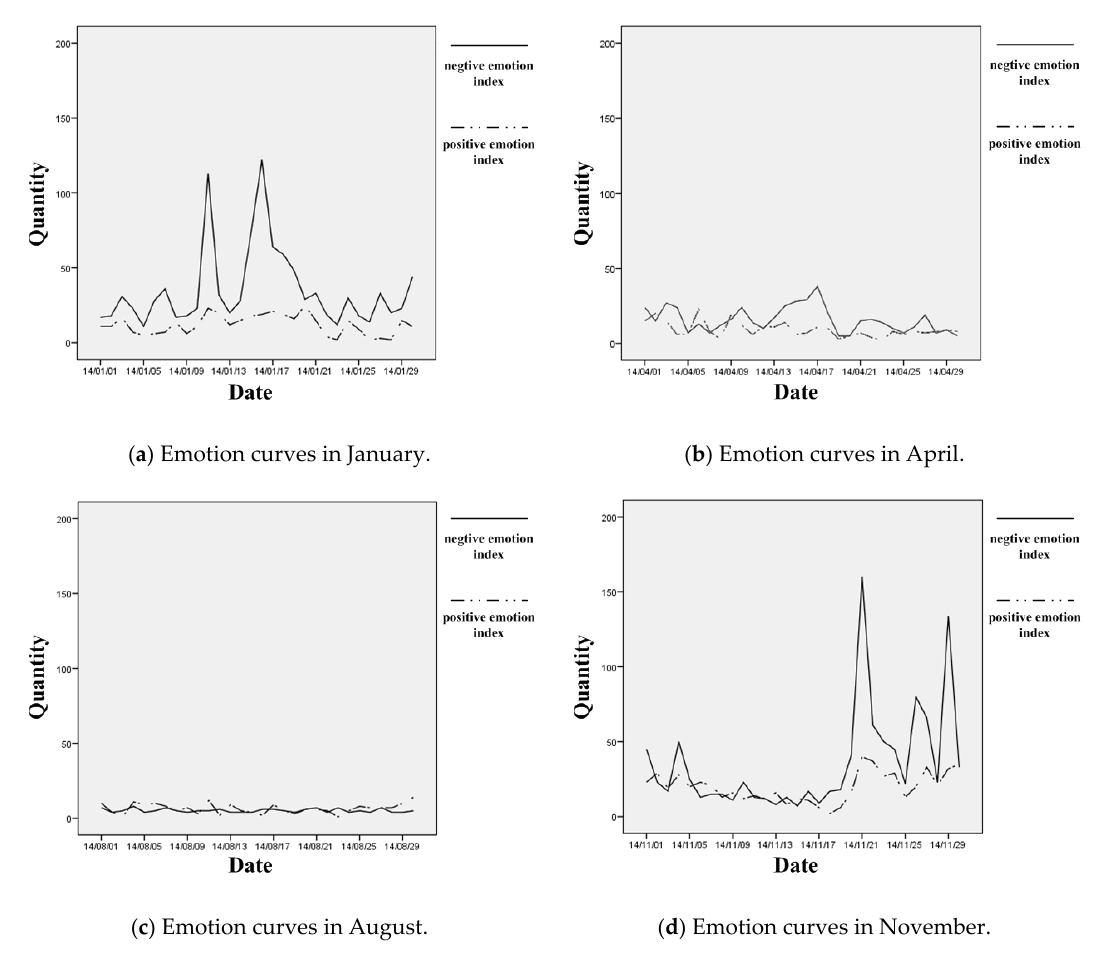
Figure 6. The positive and negative emotion curves in the four sample months.